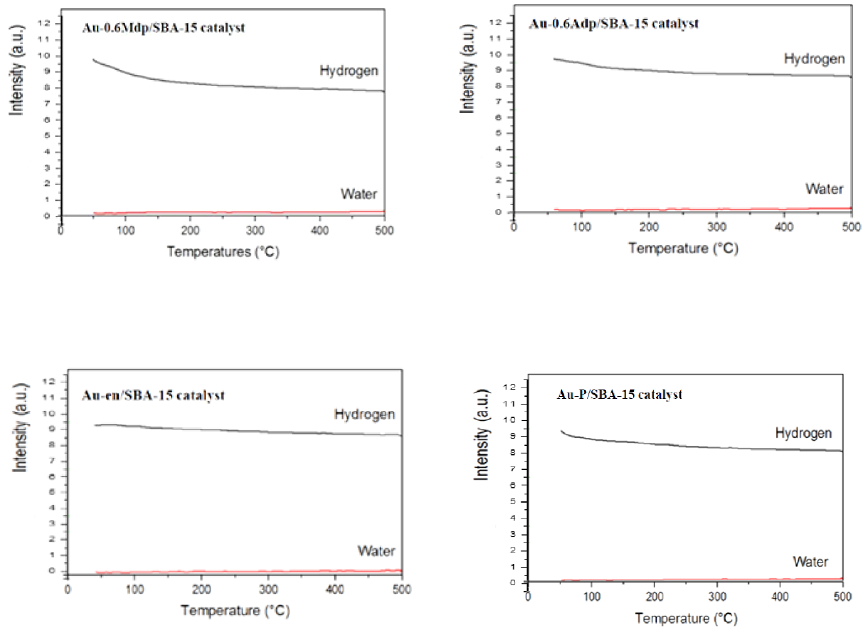
Figure 2. H 2 –Temperature Programmed Reduction of the fresh samples. Figure 2. H 2 – Temperature Programmed Reduction of the fresh samples.